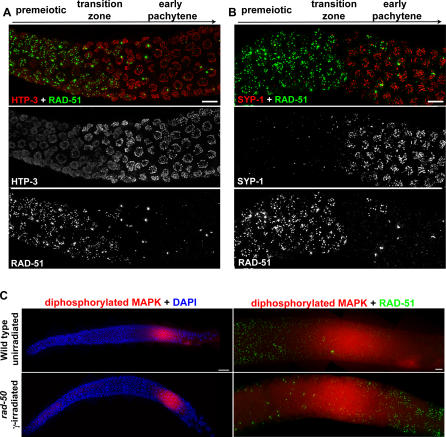
RAD-50 Dependence for Loading of RAD-51 at IR-Induced Breaks Extends from Meiotic Prophase Onset to the Mid-Pachytene/Late Pachytene Transition(A, B) Images show a portion of the germ lines of rad-50 mutant hermaphrodites fixed 1 h after exposure to 1 krad γ-irradiation, centered on the transition zone and extending from prior to the onset of meiotic prophase (premeiotic, left) through early pachytene (right). (A) HTP-3 staining is diffusely associated with chromatin in premeiotic nuclei, then becomes concentrated on chromosome axis structures at the beginning of the transition zone, first appearing as discontinuous stretches and then as extended continuous linear structures. IR-induced RAD-51 foci are abundant in nuclei with diffuse HTP-3 staining, whereas nuclei with concentrated meiotic HTP-3 signals have very few RAD-51 foci. Scale bar = 5 μm (B) SYP-1 immunostaining is either absent or detected as a single bright focus in premeiotic nuclei, and is extensively localized on chromosomes beginning in the transition zone. IR-induced RAD-51 foci are abundant in nuclei lacking SYP-1, whereas nuclei with abundant SYP-1 have very few RAD-51 foci. Scale bar = 5 μm.(C) An unirradiated wild-type gonad and an irradiated rad-50 gonad stained with DAPI, α-RAD-51, and a monoclonal antibody detecting the activated, diphosphorylated form of MAP kinase (MAPK). Left, zoomed out view of the gonads (distal tip through diplotene), showing the position of the peak of MAP kinase activation that occurs at the mid-pachytene to late pachytene transition. Right, zoomed in view of the region surrounding this peak of activated MAP kinase, showing the location of this peak relative to RAD-51 foci. In the unirradiated wild-type germ line, RAD-51 foci peak in mid-pachytene and diminish in numbers prior to the peak of activated MAPK. In the irradiated rad-50 germ line, background levels of bright SPO-11-independent spontaneous RAD-51 foci are seen in a subset of nuclei throughout the gonad, whereas IR-induced RAD-51 foci abruptly rise in abundance in late pachytene nuclei, after the peak of activated MAPK. Left; Scale bar = 20 μm. Right; Scale bar = 5 μm.